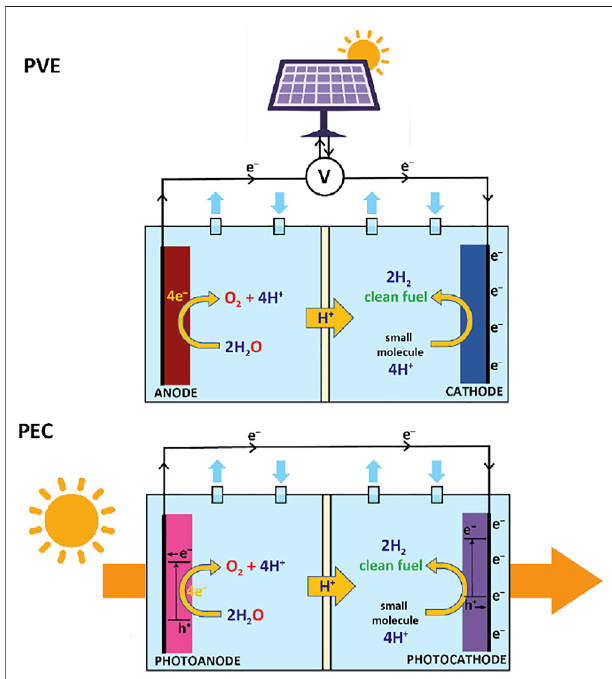
FIGURE 2 | Schemes of photovoltaic-coupled electrolyzers ( PVE ) and photoelectrochemical cells ( PEC